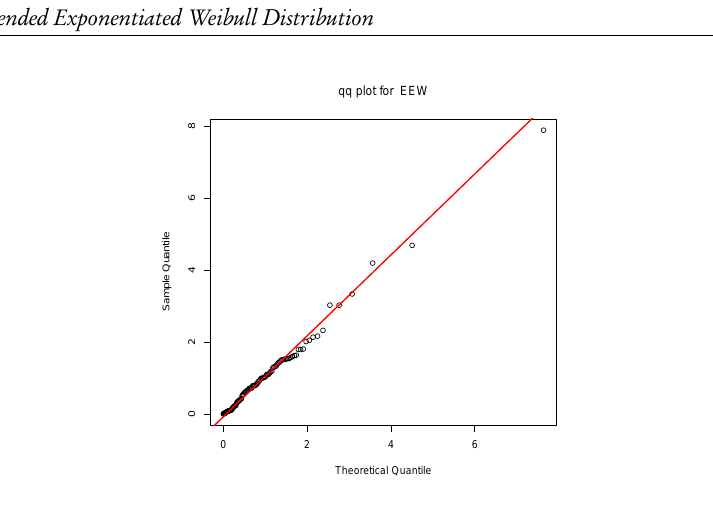
Figure 6 – QQ-plot of EEW model for Andrews and Herzberg